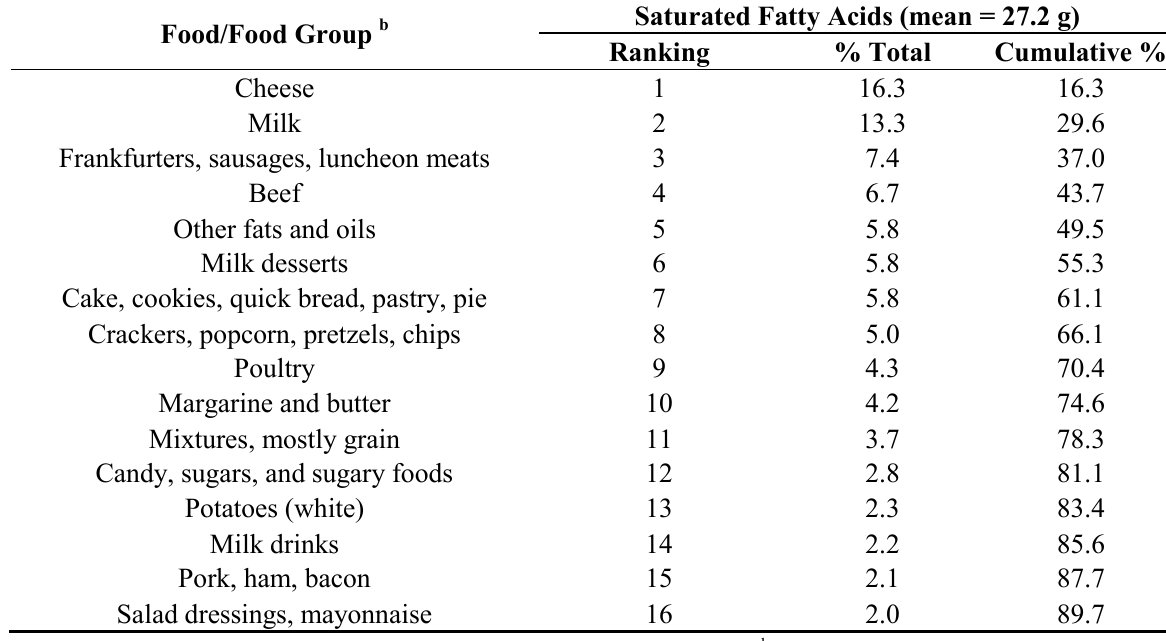
Table 8. Food/Food group sources of saturated fatty acids among US children aged 2–18 years (from NHANES 2003–2006) a